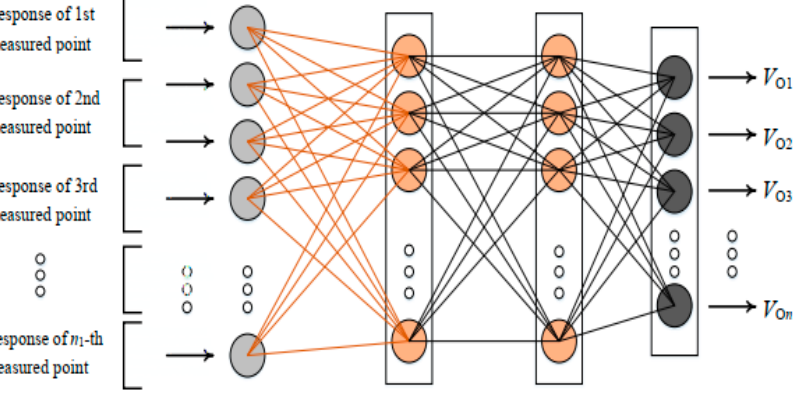
Figure 1. ANN architecture with two hidden layers.